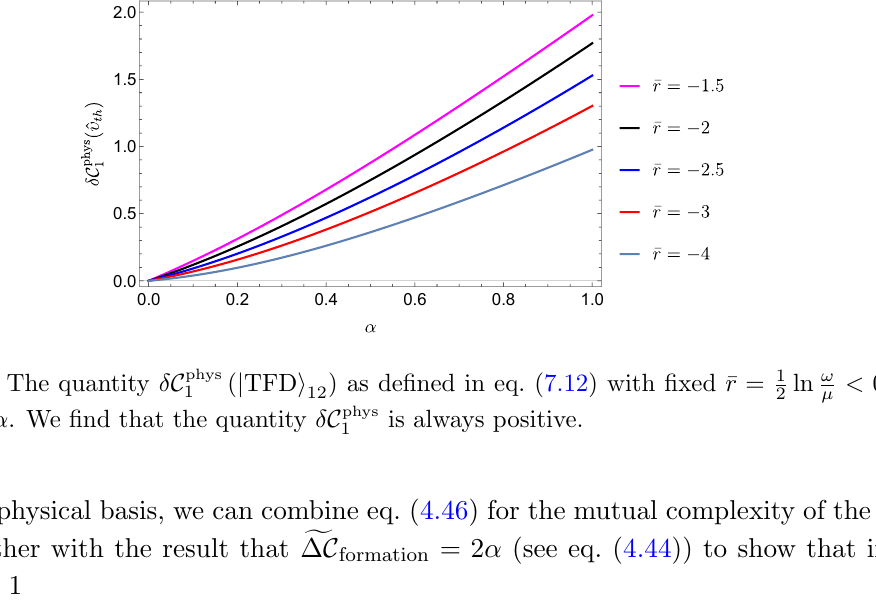
ln ! < 0 as a 2 (cid:22)